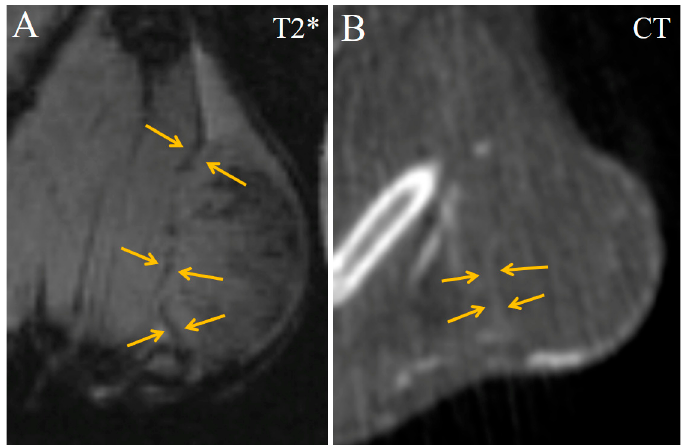
Figure 7. Coronal images of Ca755 mammary carcinoma. ( A ) T2*MRI 16 min post injection of Fe 3 O 4 @Au; ( B ) CT image 22 min post injection of Fe 3 O 4 @Au. Enhanced lines in the inner periphery (related to the tumor capsule) distinguish the tumor from adjacent muscle.